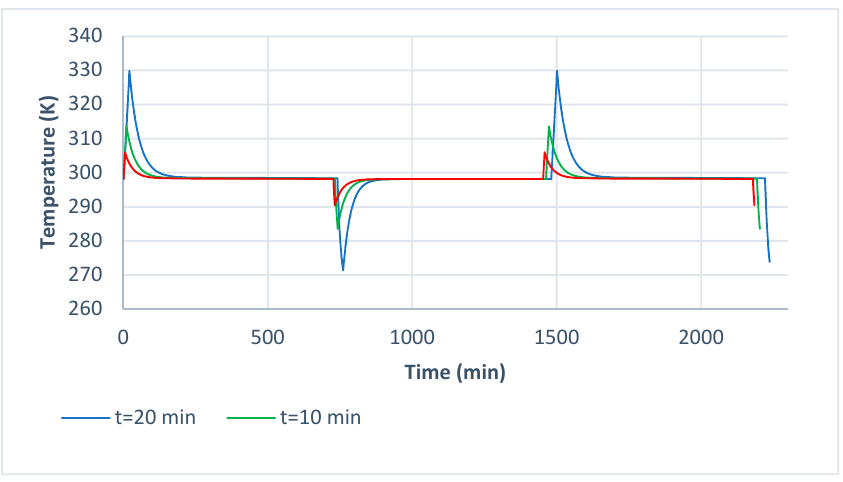
Figure 17. Gas temperature trend for the Second Configuration varying the charging time. Figure 18. Gas pressure trend for the First Configuration varying the charging time .